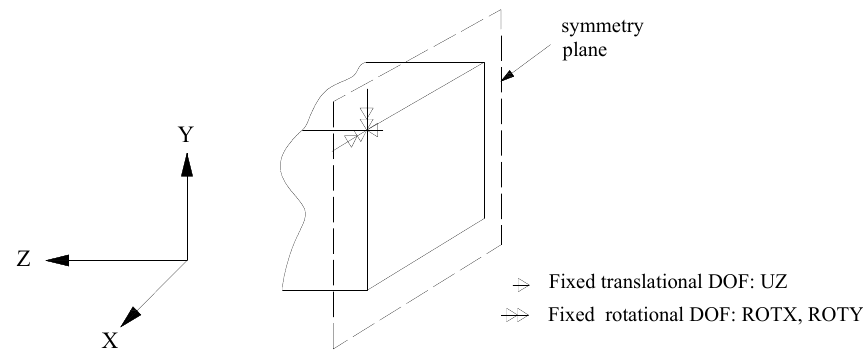
Figure 11. Schematic of symmetric constraints used in the midspan section.